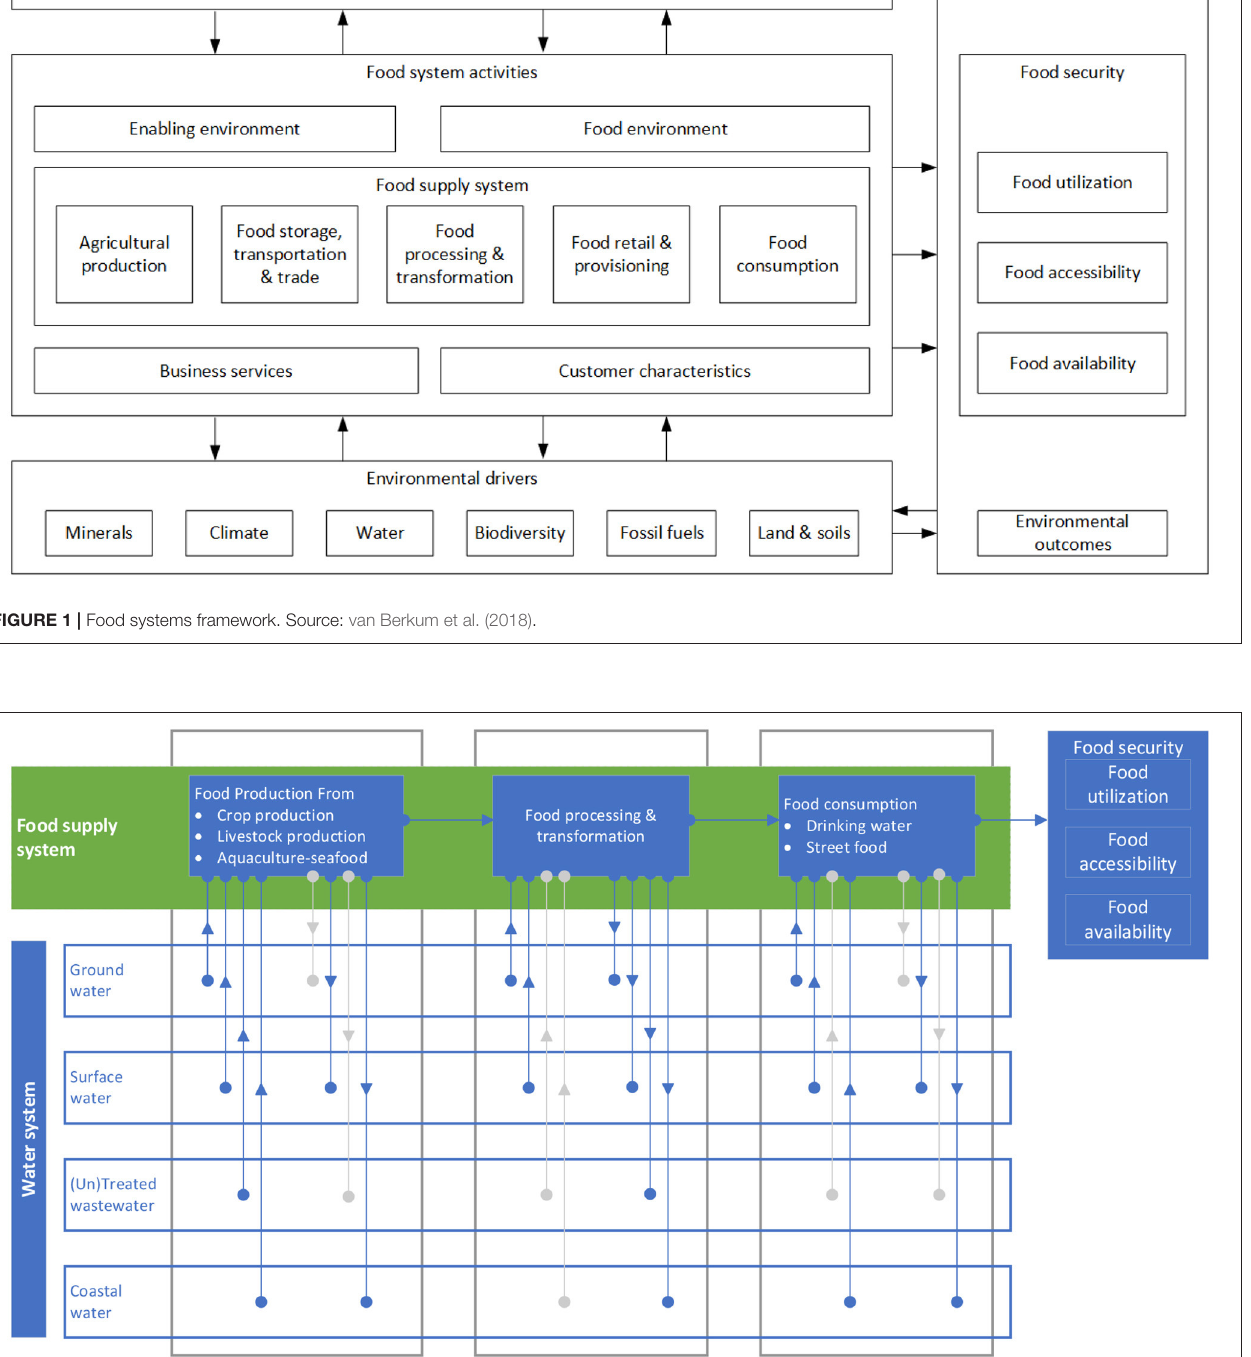
Frontiers in Water |